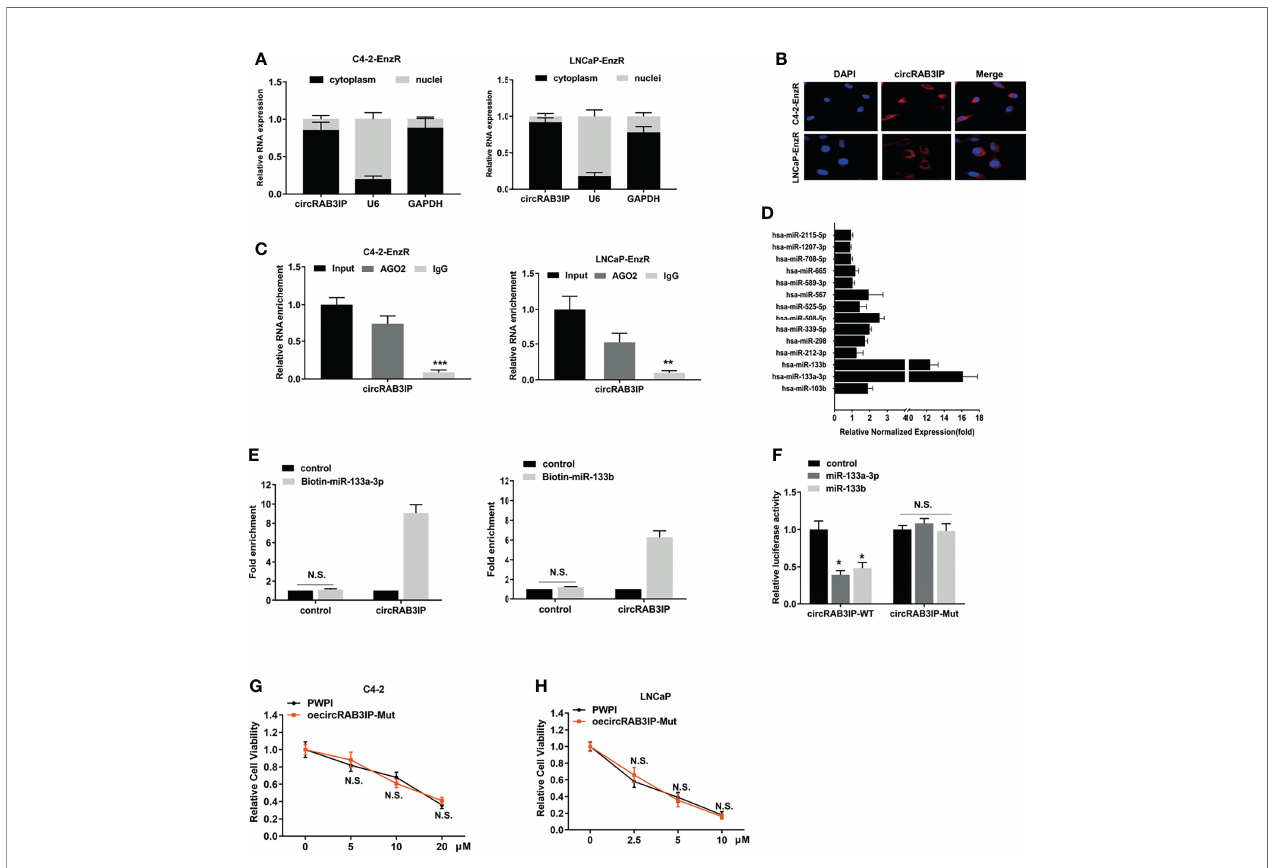
FIGURE 3 | (A) Nuclear mass separation assays indicated the location of circRAB3IP, RAB3IP, U6 and GAPDH in C4-2-EnzR and LNCaP-EnzR cells. (B) RNA- FISH indicated the location of circRAB3IP in C4-2-EnzR and LNCaP-EnzR cells. (C) AGO2-RIP assays were performed using an antibody against AGO2 on extracts and detected by qRT-PCR assays in C4-2-EnzR and LNCaP-EnzR cells. (D) circRIP assays were performed in C4-2-EnzR cells using a circRAB3IP-speci fi c probe, and the enrichment of miRNAs was detected by PCR. (E) A pull-down assay for biotin-labeled miRNA was used to evaluate the binding properties between miR- 133a-3p/miR-133b and circRAB3IP in C4-2-EnzR cells. (F) A dual luciferase reporter assay was used to prove the binding properties between miR-133a-3p/miR- 133b and circRAB3IP. (G) C4-2 cells were treated with different concentrations of Enz as indicated after overexpressing circRAB3IP-Mut or not (PWPI), and cell viability was evaluated by CCK-8 assay. (H) LNCaP cells were treated with different concentrations of Enz as indicated after overexpressing circRAB3IP-Mut or not (PWPI), and cell viability was evaluated by CCK-8 assay. Data are presented as mean ± SEM. *P < 0.05, **P < 0.01, ***P < 0.001 compared with the controls. N.S., not signi fi cant compared with the